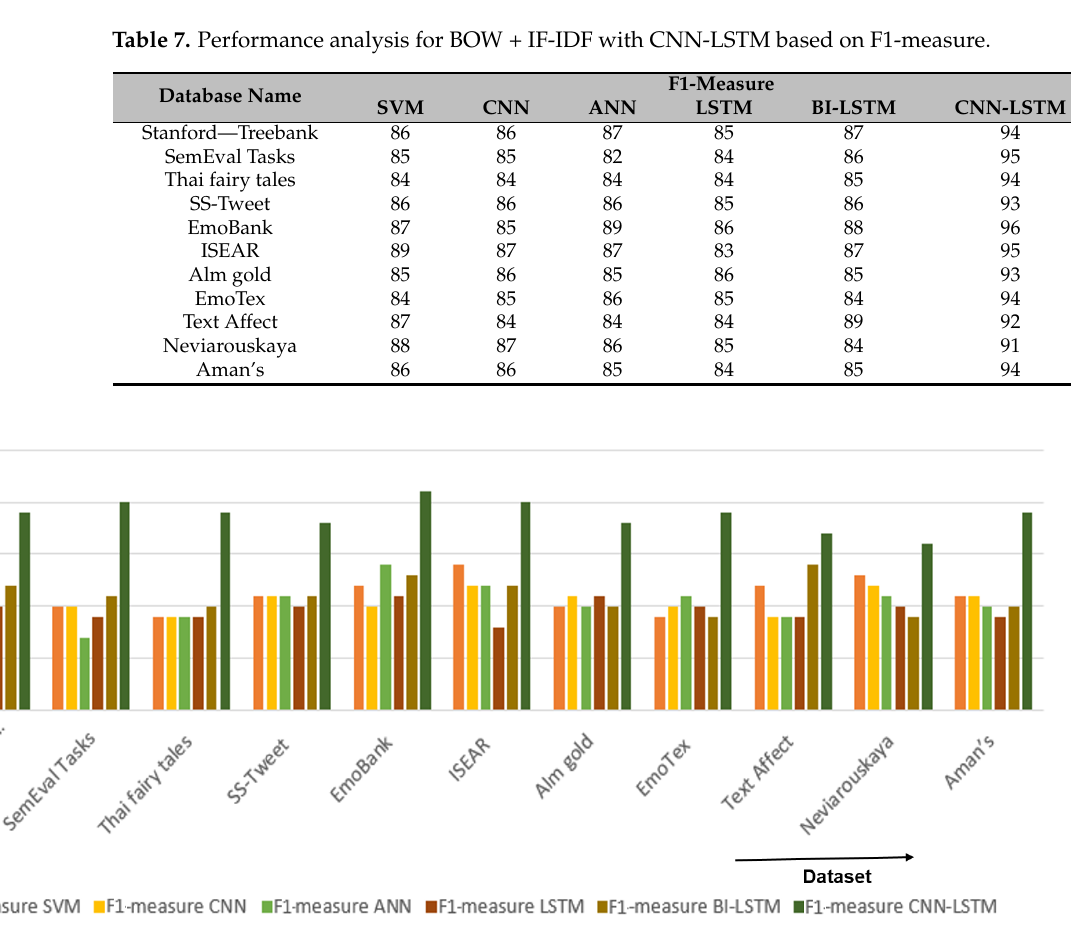
Figure 12. Performance analysis for BOW + IF-IDF with CNN-LSTM based on F1-measure. (“Stanford Sentiment...” means “Stanford Sentiment